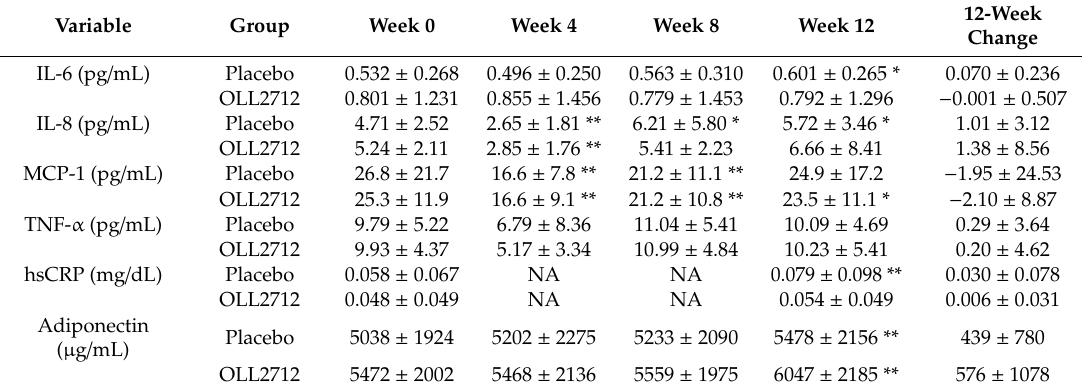
Table 4. Serum pro-inflammatory cytokines, high-sensitivity C-reactive protein, and adiponectin.